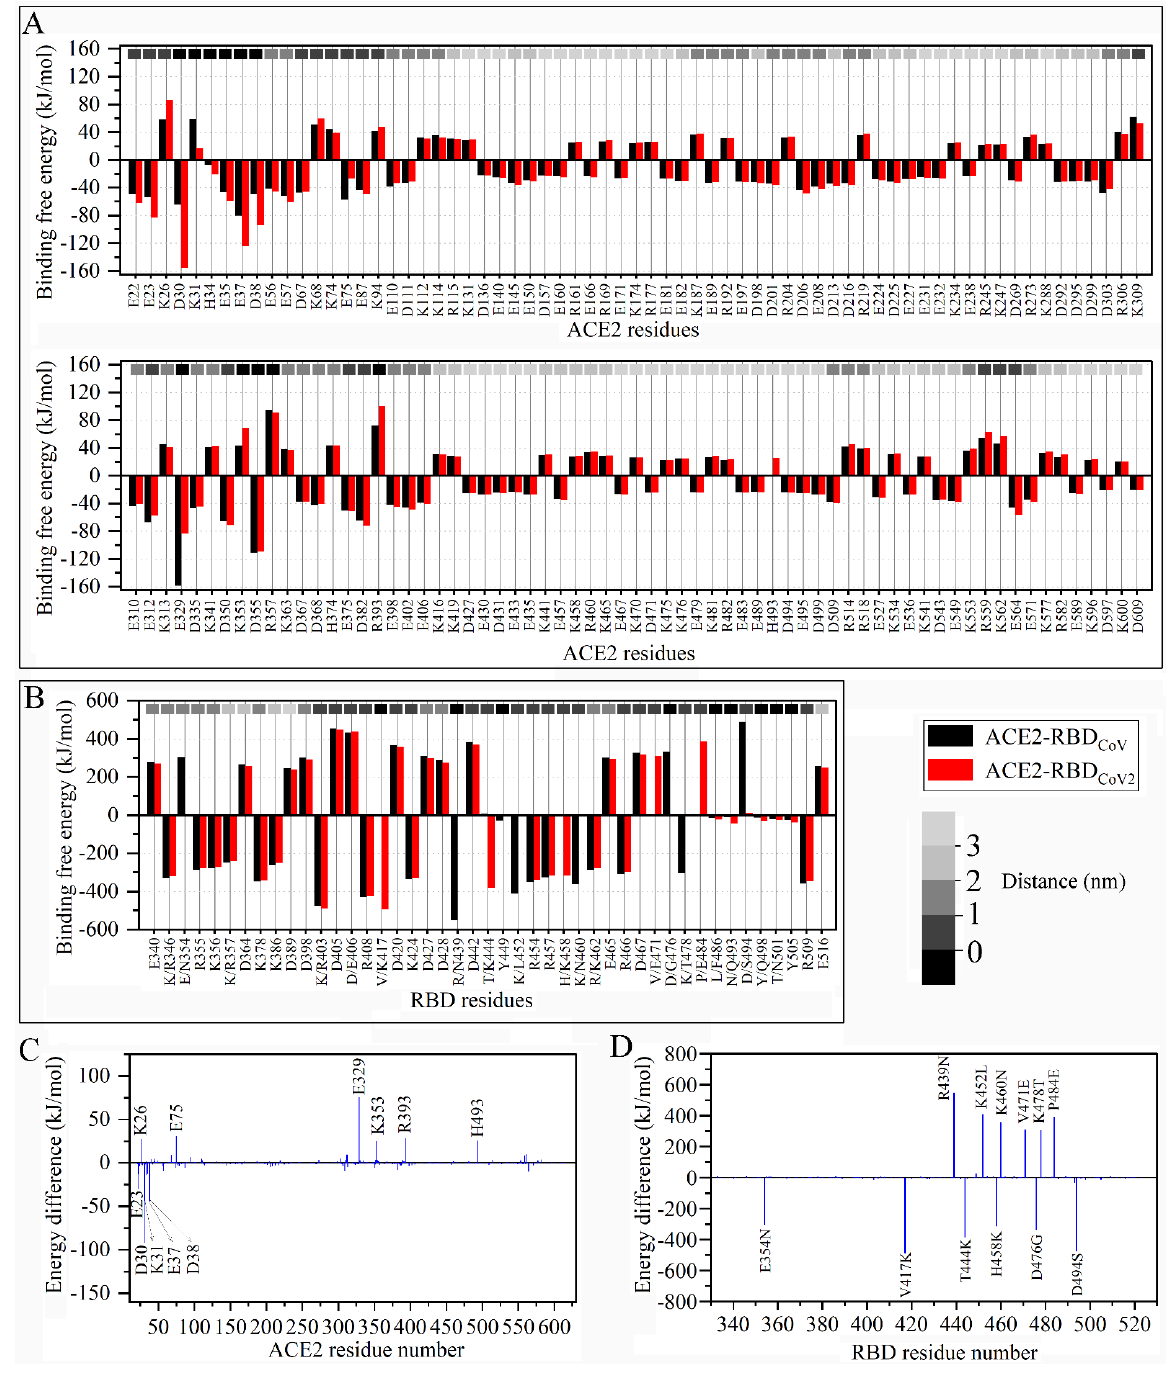
Figure 4. Residue binding free energy (BFE) average values and their differences between the RBD CoV -ACE2 and RBD CoV2 -ACE2 complexes. ( A ) Residue BFE average values of the RBD CoV -bound (black) and RBD CoV2 -bound (red) ACE2s. ( B ) Residue BFE average values of RBD CoV (black) and RBD CoV2 (red). In (A and B), only the residues with BFE values greater than 20 kJ/mol or lower than − 20 kJ/mol are shown. The distances of residues to the binding interfaces are marked by small rectangles of different shades of gray along the top horizontal axis, with the black rectangles representing the distance of 0 nm (corresponding to the interface residues identified in this work) and those of reduced gray representing the increased distance to the binding interfaces as indicated by the gray bar.